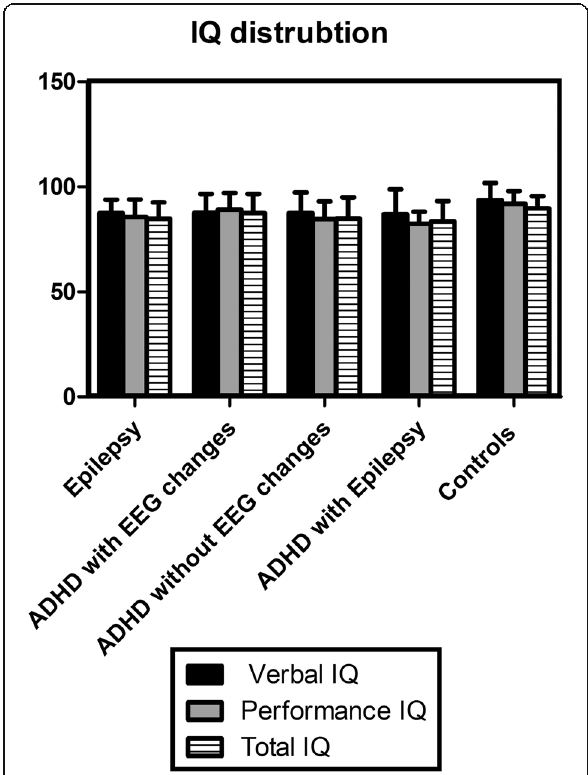
Fig. 1 Wechsler Intelligence Scale for Children-3 (WISC-III) score among the studied groups